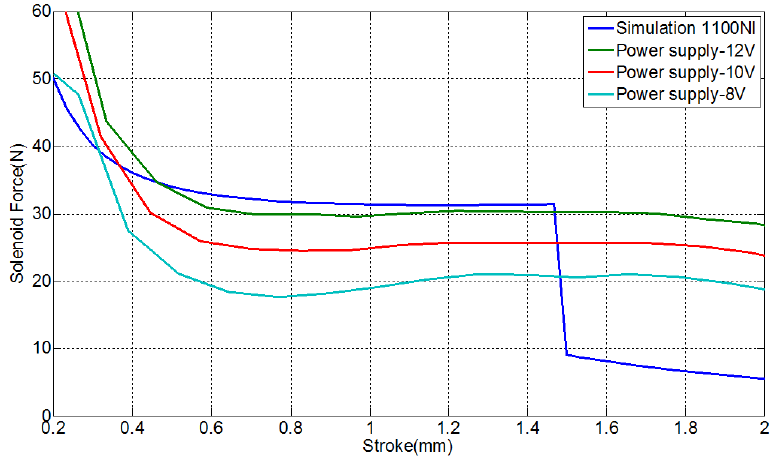
Figure 17. Simulation and test results for the proportional valve solenoid force.